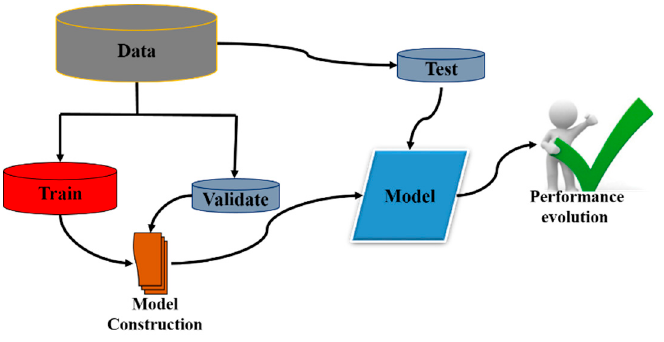
Figure 8. Processes of context prediction.